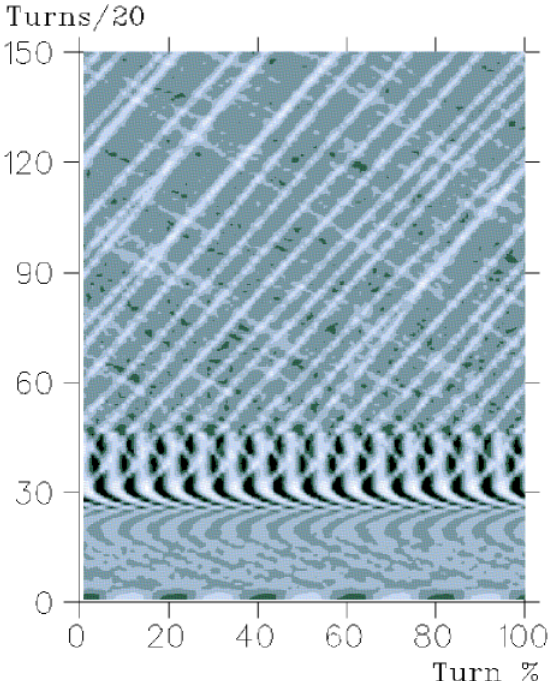
FIG. 20. Waterfall plot of line density, 2400 turns, 4 3 10 12 protons. Beam has artificial initial 6 5% density modulation which very quickly debunches.